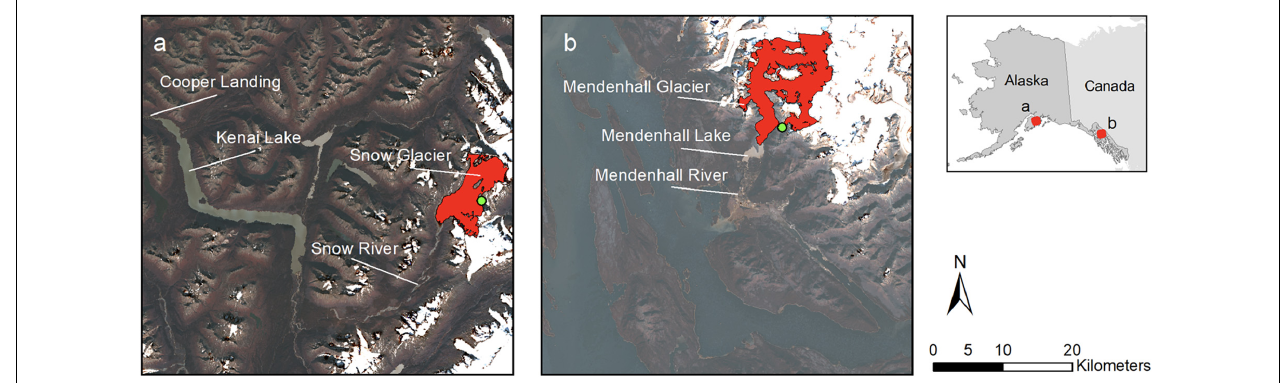
FIGURE 1 | Location of Snow Glacier (a) , Kenai Peninsula and Mendenhall Glacier (b) , Juneau in Alaska. Green dots show the location of the studied glacial lakes. Background imagery is based on LandsatB images from 2018. The glacier outlines (in red) are based on (Kienholz et al., 2015) JG!ac Inventory (DOI: